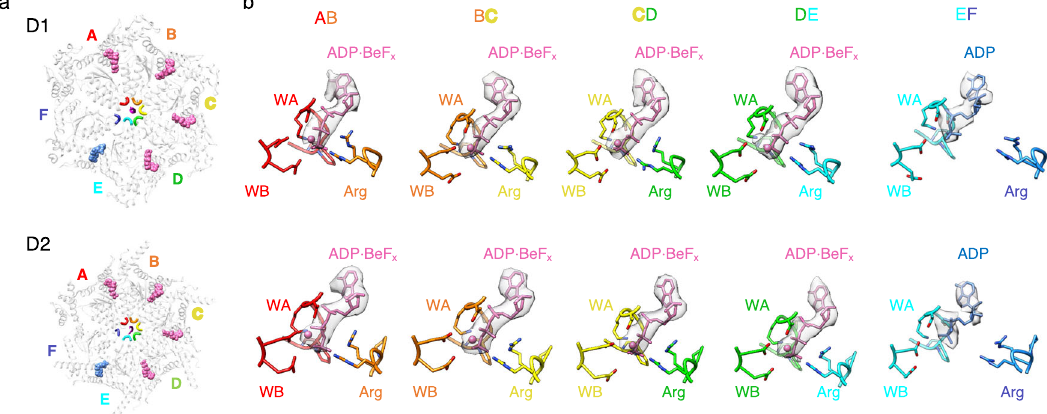
Fig. 2 Nucleotide binding pockets. a Top view of substrate-bound p97 hexamer with nucleotide models at subunit interfaces (pink spheres, ADP ⋅ BeF x ; blue spheres, ADP). Top row, D1 ring; bottom row, D2 ring. b Closeup views of nucleotide-binding pocket motifs with nucleotide density and model.